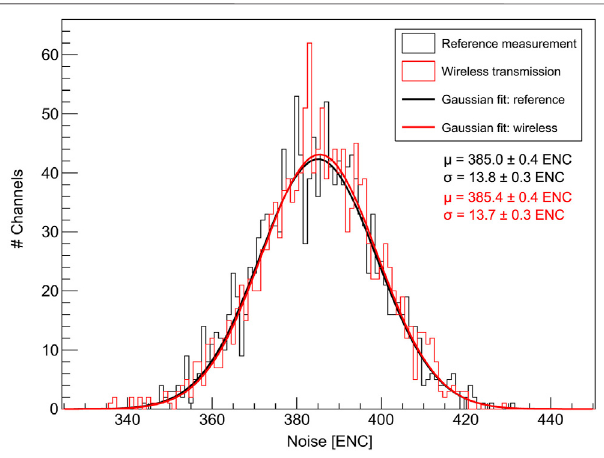
FIGURE 12 | Noise distribution of all channels of the 12 ABCN readout chipswithoutstripsensorsunderirradiation.Thereferencemeasurementwas performedwithout60 GHzirradiation.Mean μ and width σ oftheGaussian fi ts are given. No signi fi cant difference is observed [26].